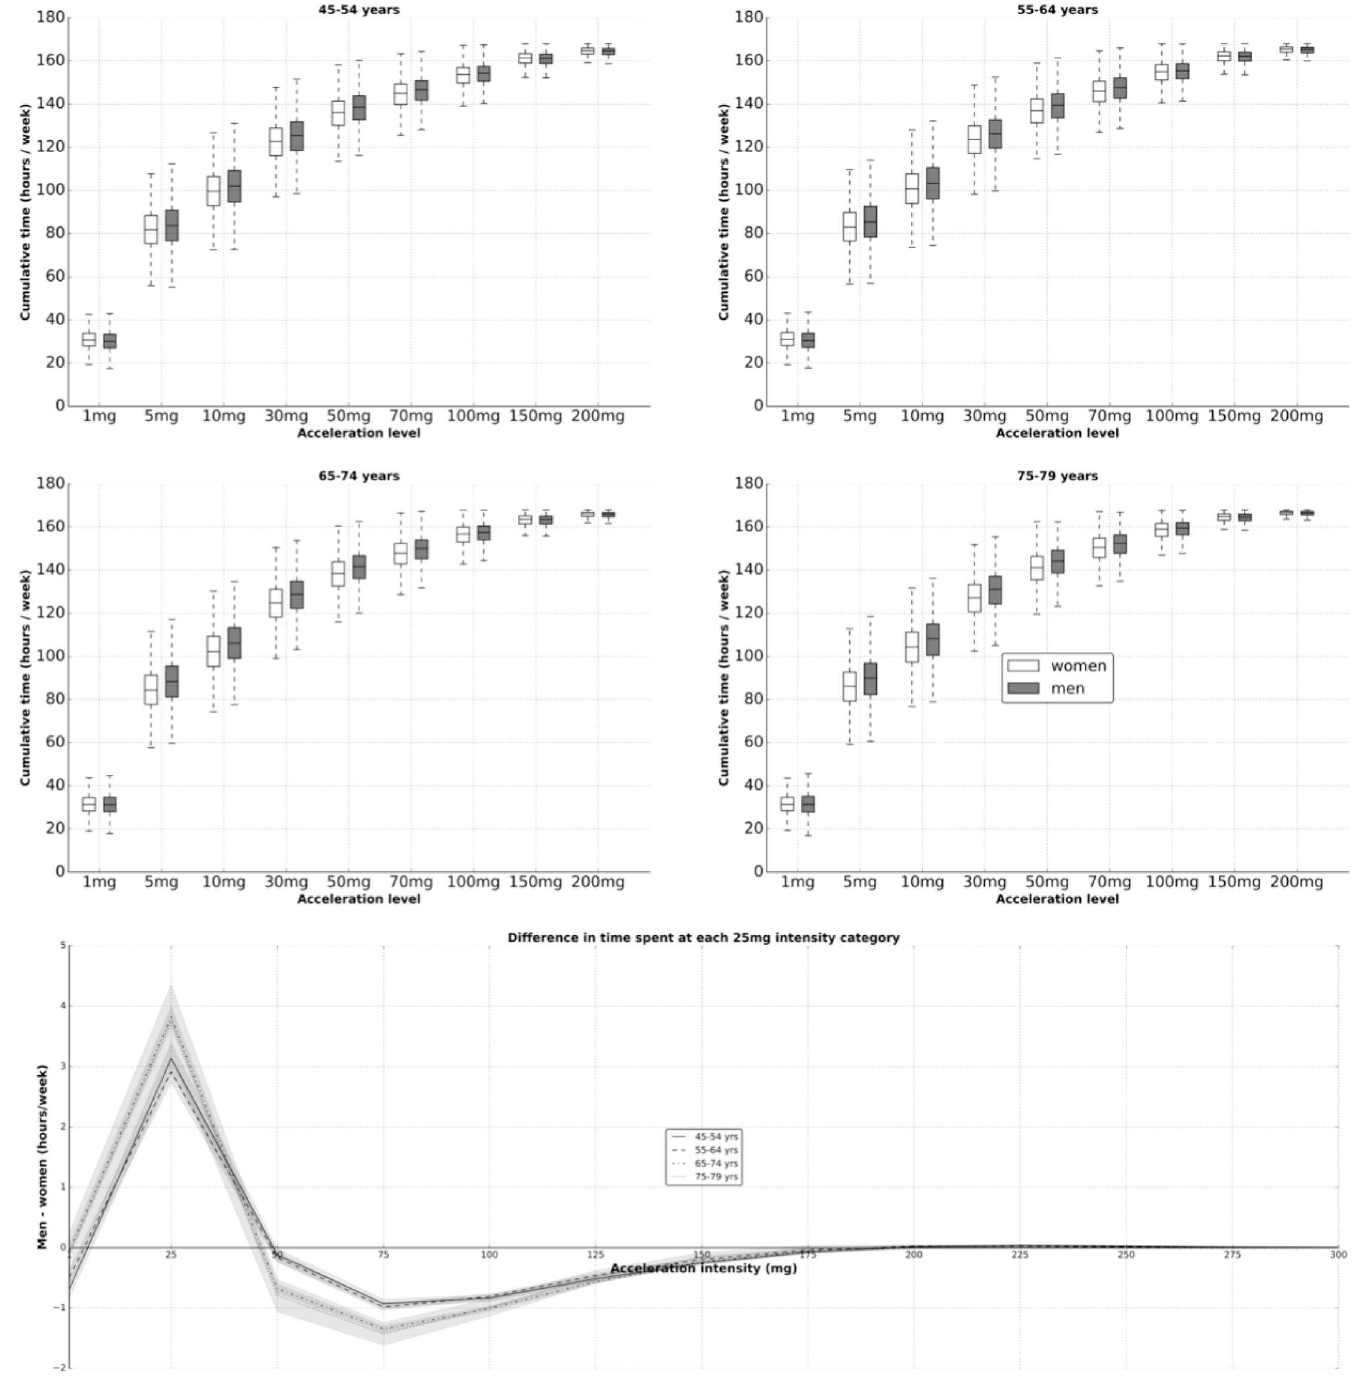
Fig 7. Cumulative time spent in various acceleration categories by sex and age (top), and sex differences by age and intensity level (bottom); the UK Biobank study 2013–2015(n =